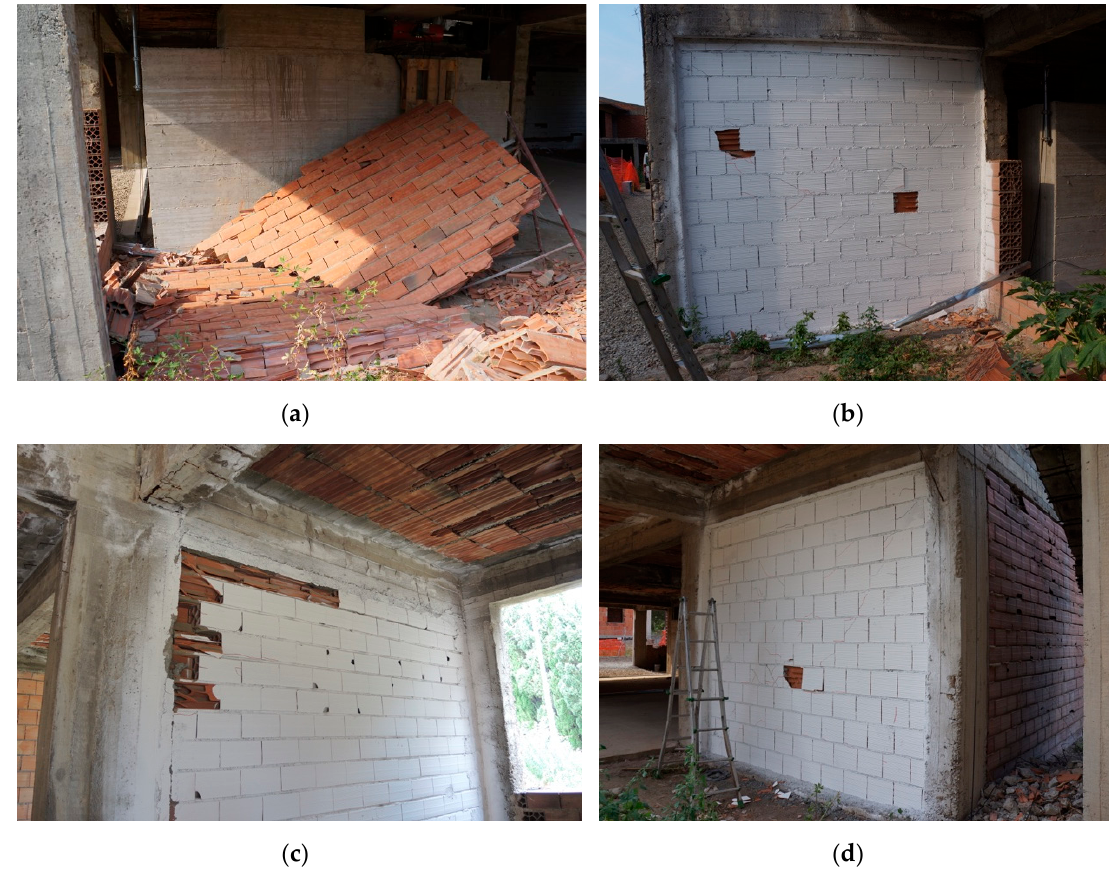
Figure 13. Infill damage at run #4, 9.6 mm—0.26%: Infill i5 ( a ); infill i3 ( b ); infill i10 ( c ); infilli11 ( d ).